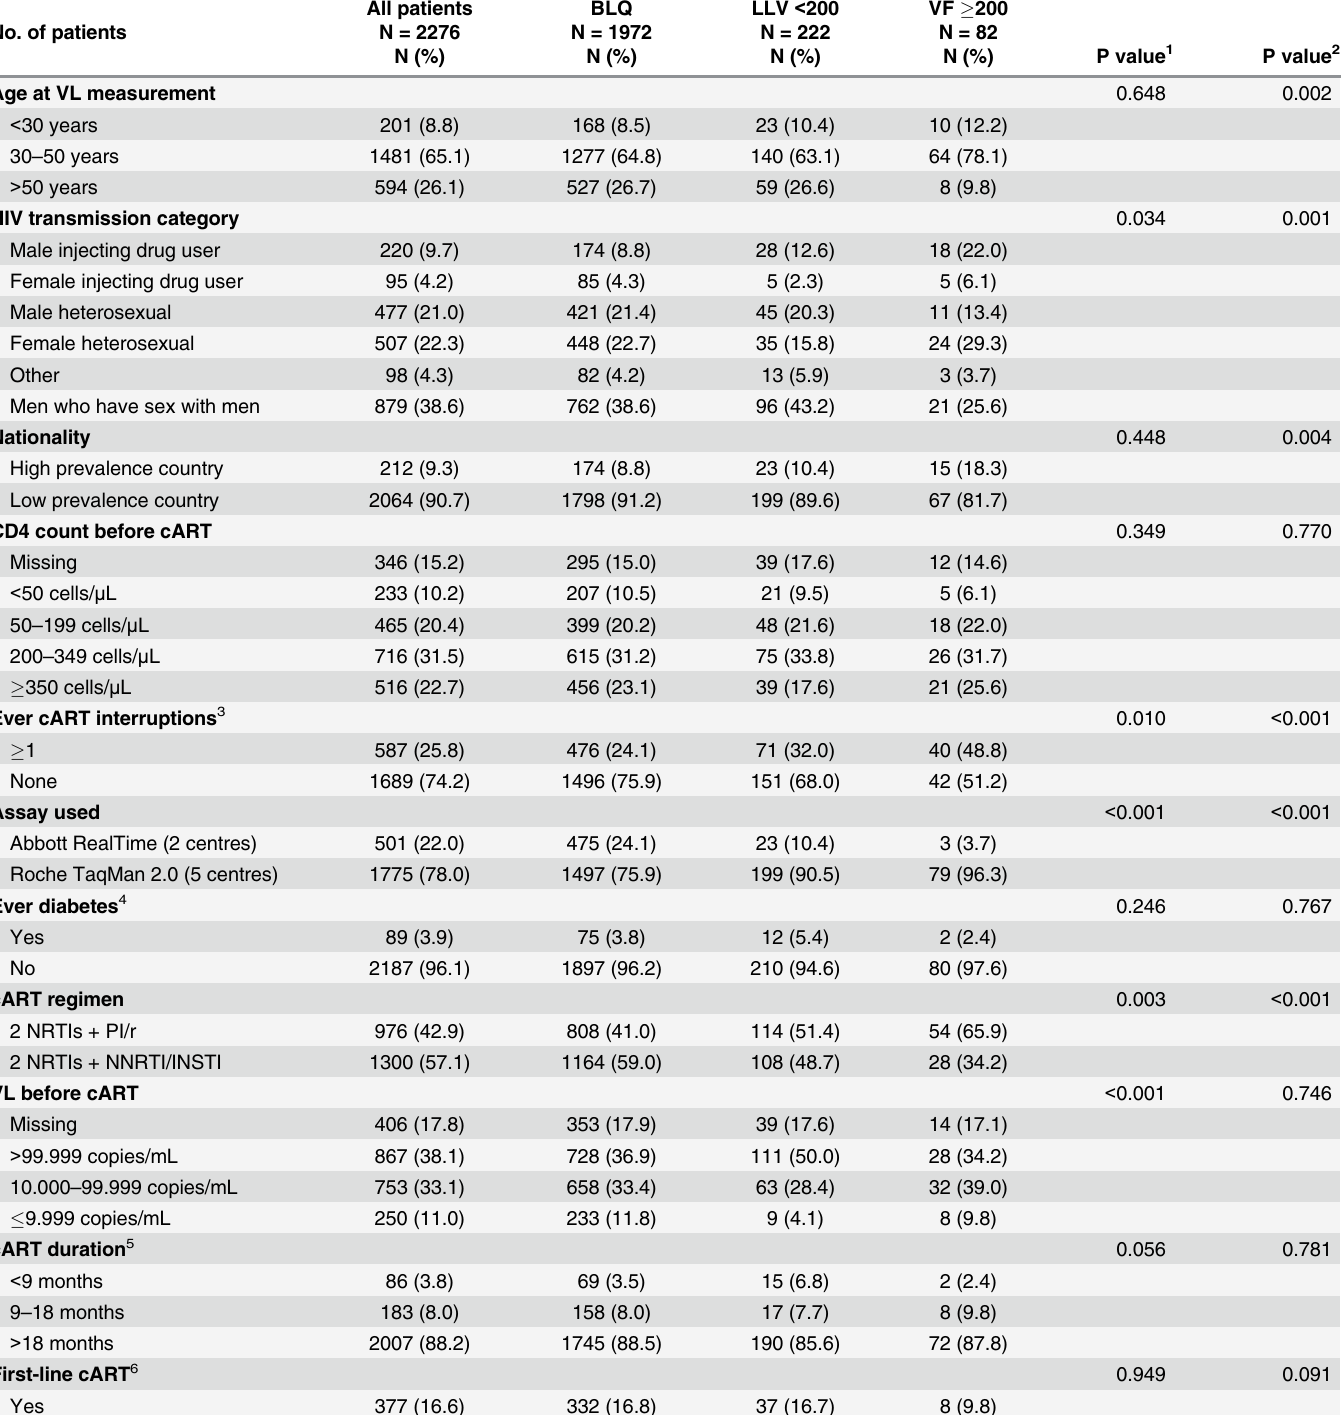
Table 1. Characteristics of patients stratified by HIV RNA levels below the limit of quantification and low-level viraemia defined as quantifiable HIV RNA levels < 200 copies/mL and virological failure defined as HIV RNA levels (cid:1) 200 copies/mL. All